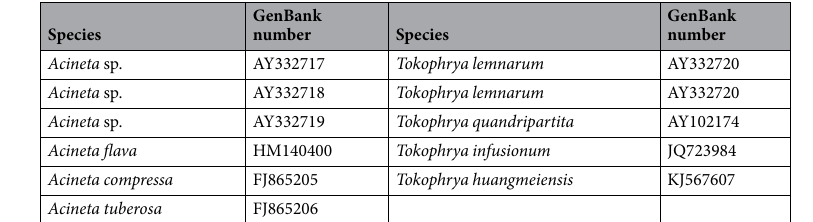
Table 1. Accession numbers of the species used for the phylogenetic